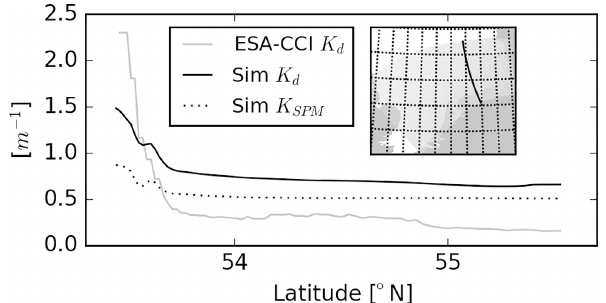
Figure B1. Total light attenuation along the transect shown in the inset as estimated by the satellite product (ESA-CCI K d , solid gray line) and by the model at the surface layer (Sim K d , solid black line). Light attenuation caused only by SPM used as model forc- ing is shown separately (Sim K SPM , solid dotted line). All values represent averages between 2008 and 2010. The satellite estimates are from 490nm wavelength and the model estimates represent the average within the PAR (400–700nm) spectrum.